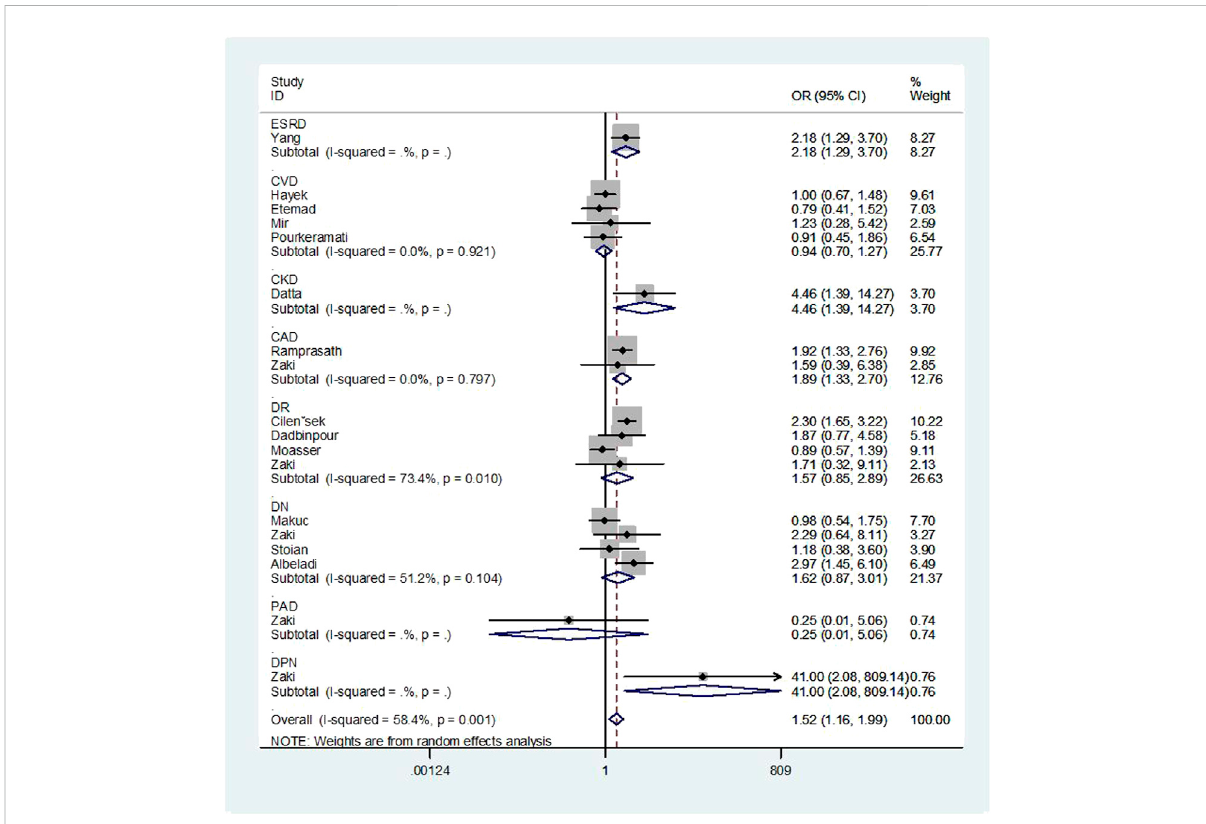
FIGURE 3 Forest plot of the association between GSTM1 polymorphism and T2DM complications